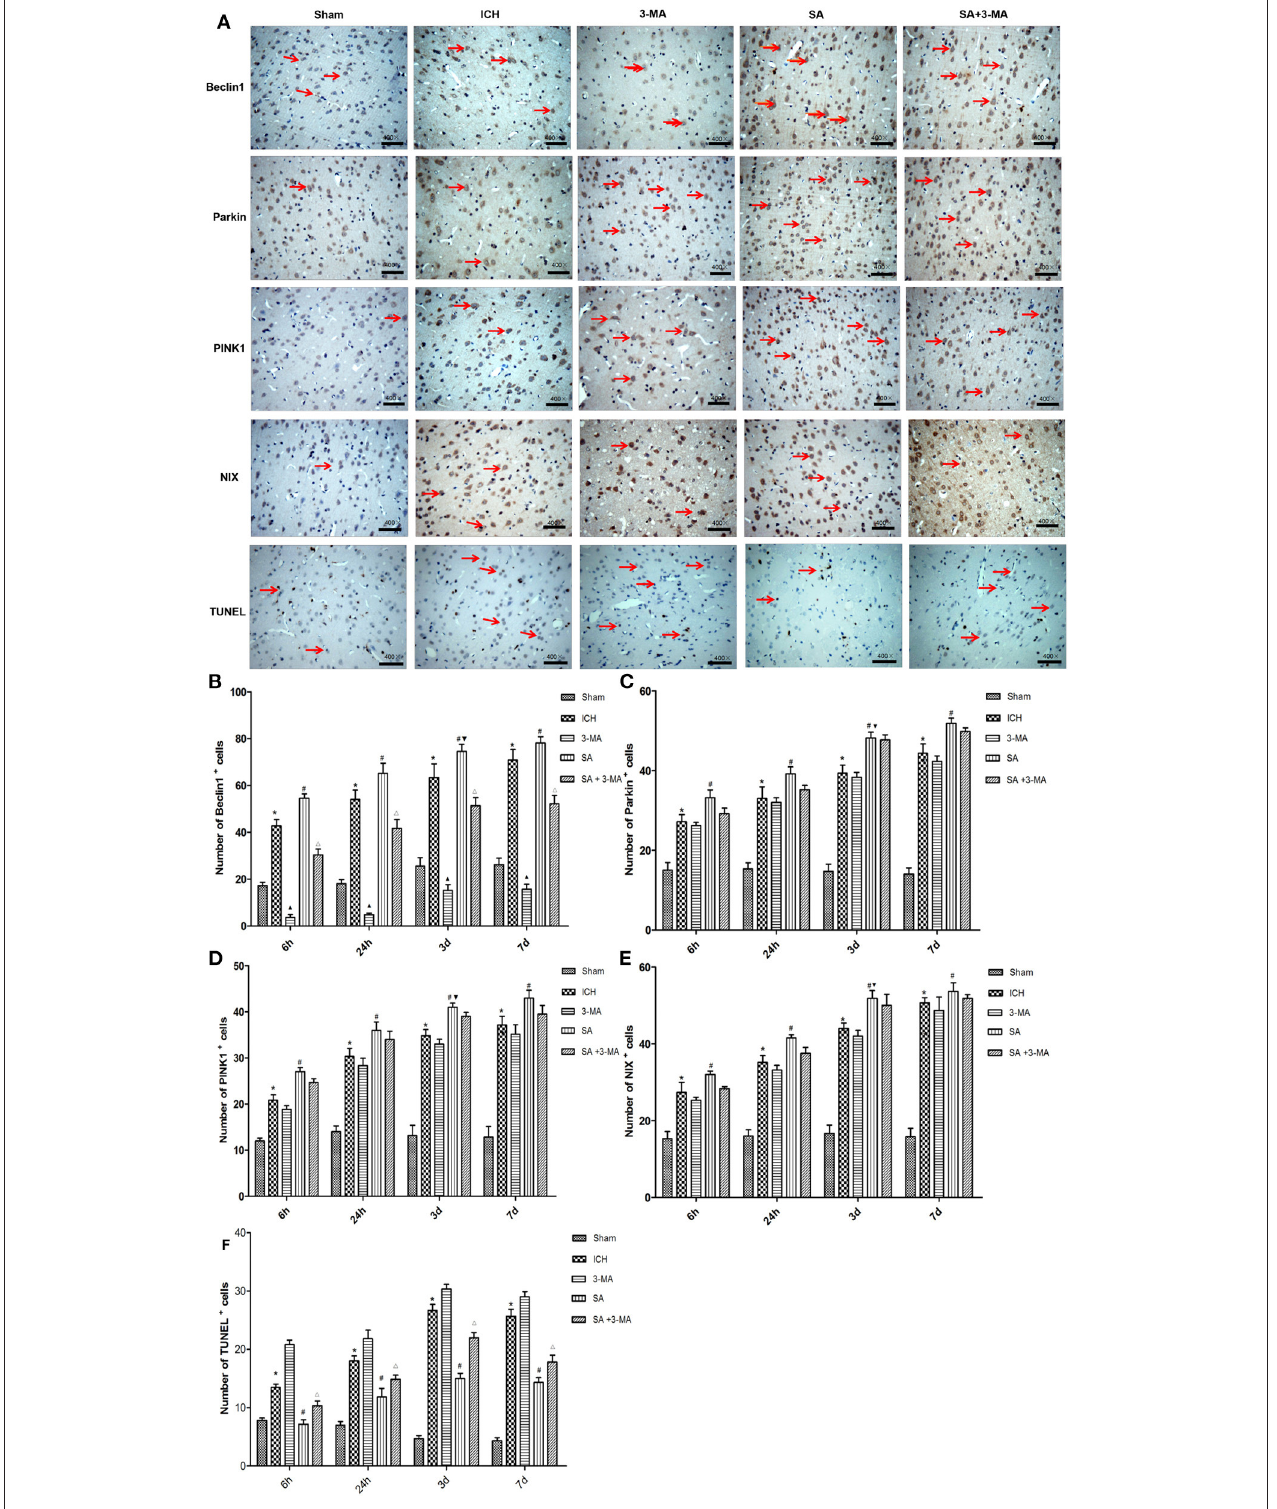
FIGURE 6 | Immunohistochemistry: SA upregulates mitophagy-related proteins and decrease the number of TUNEL positive cells after ICH. (A) Immunohistochemistry and TUNEL of brain tissue. Arrows mark positive cells. Magnification, 400 × . Scale bars, 50 µ m. (B–F) Quantitation of numbers of cells